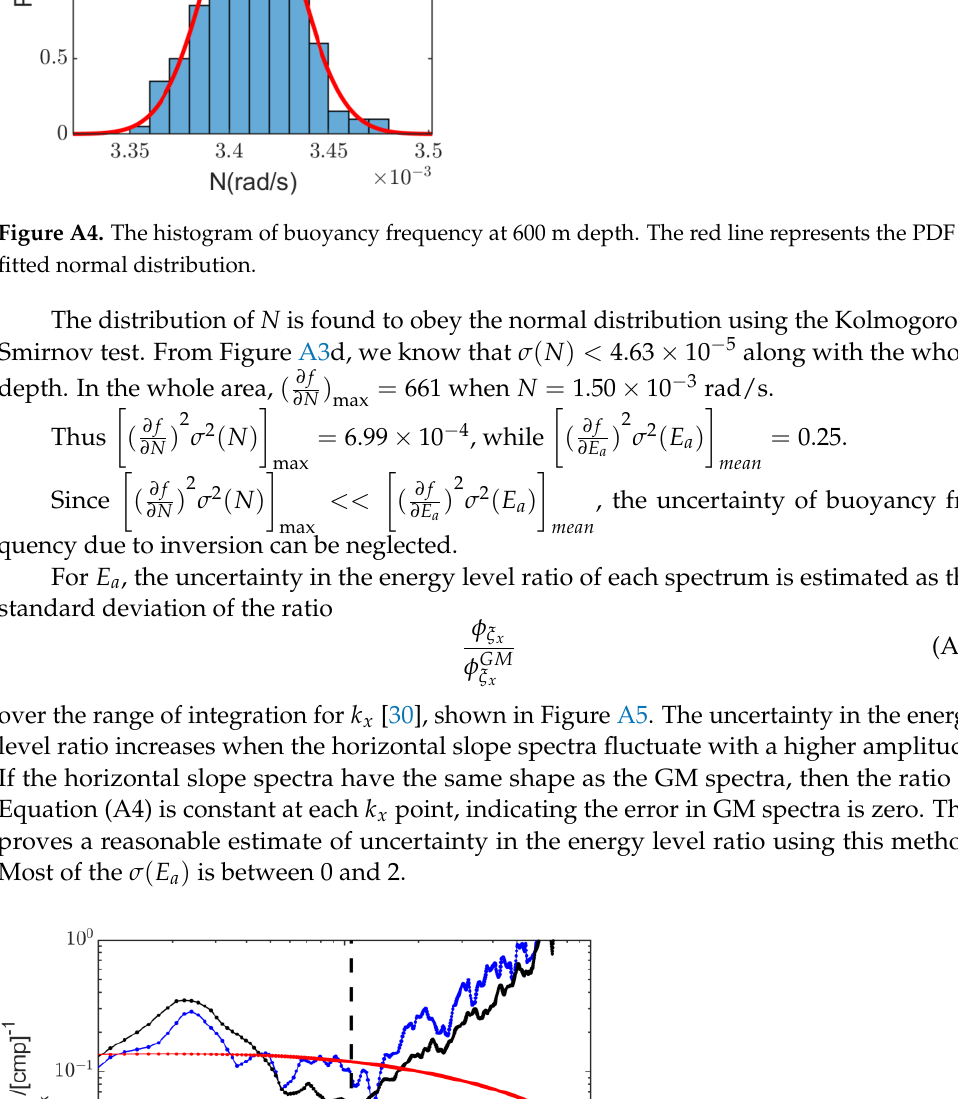
at each wavenumber. The 𝑥 x